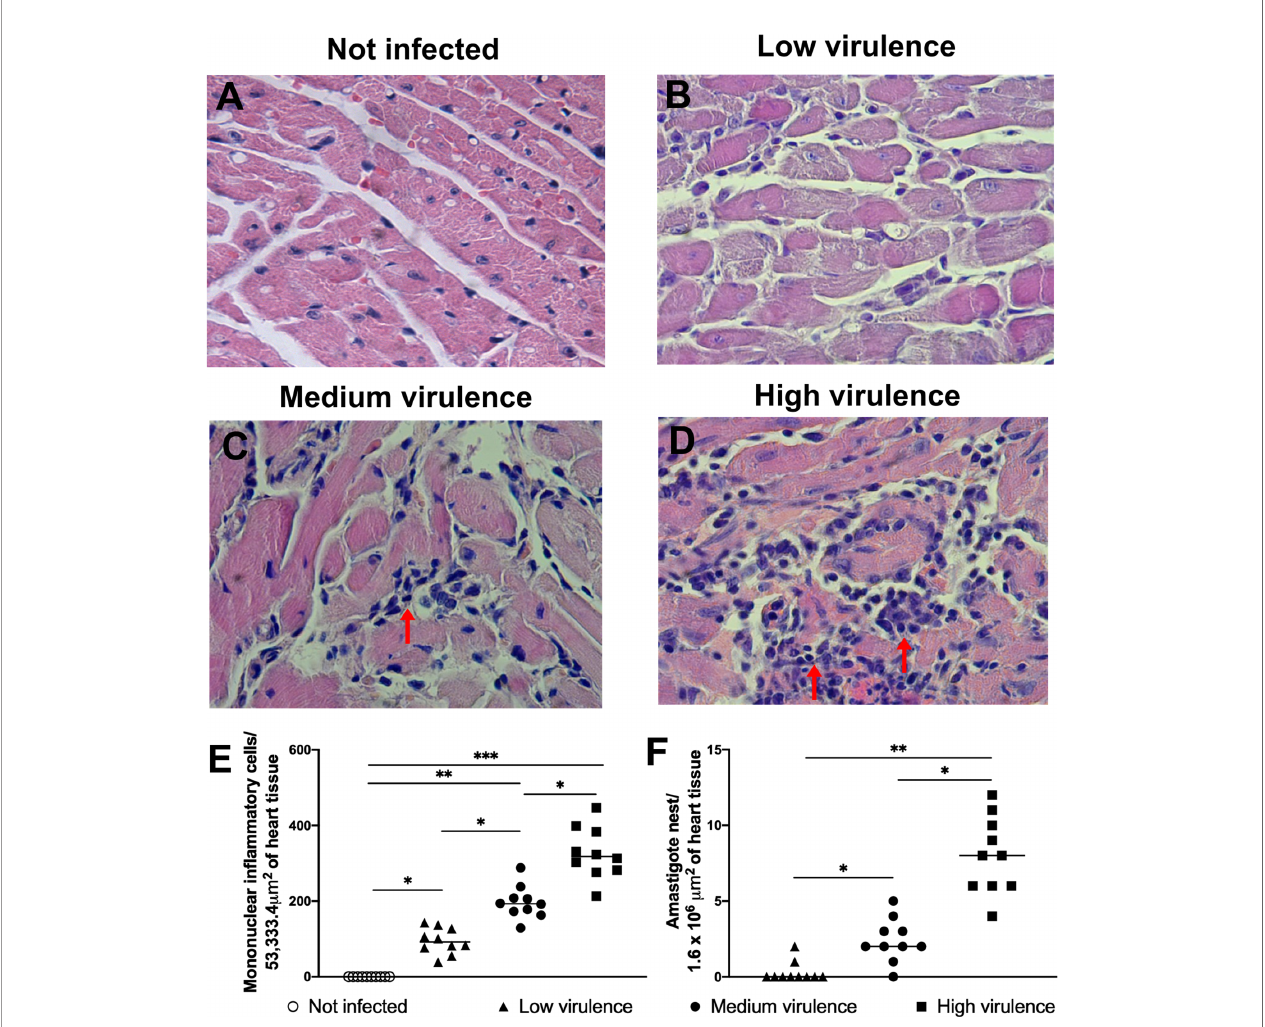
FIGURE 2 | Intensity of myocarditis in the acute phase in mice is related to Trypanosoma cruzi strain virulence. Representative histological sections of cardiac tissue from Swiss mice, not infected (A) and infected by the intraperitoneal route with 1 × 10 4 blood trypomastigote forms of T. cruzi strains that showed low (strains: AM64 + 3253) (n = 10) (B) , medium (PL1.10.14 + CL) (n = 10) (C) and high (Colombian + Y) (n = 10) (D) virulence and euthanized 15 days after infection. Quanti fi cation of in fl ammatory mononuclear cells (E) and amastigote nests (F) in the heart tissue of mice. Hematoxylin and eosin staining was used. ×400 magni fi cation. Arrow indicates parasites. The results are expressed as the means ± standard errors. * p < 0.05; ** p < 0.01; *** p <